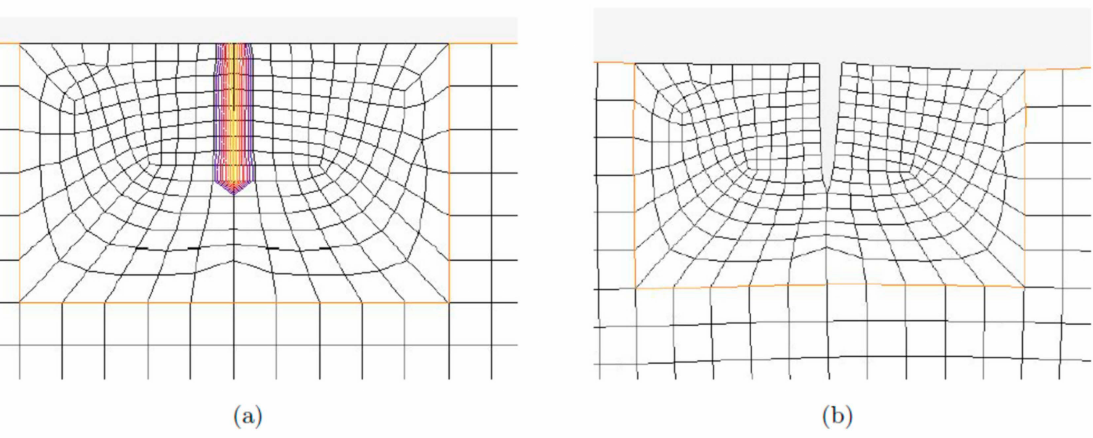
Figure 4. Breathing crack model in MSC Marc . The vicinity of the crack meshed for ( a ) closed crack; ( b ) open crack.